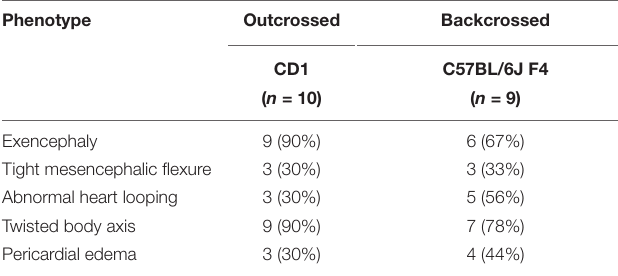
TABLE 1B | Observed phenotypic penetrance of C2cd3 ex2 / ex2 mutants on CD1 and C57BL/6J